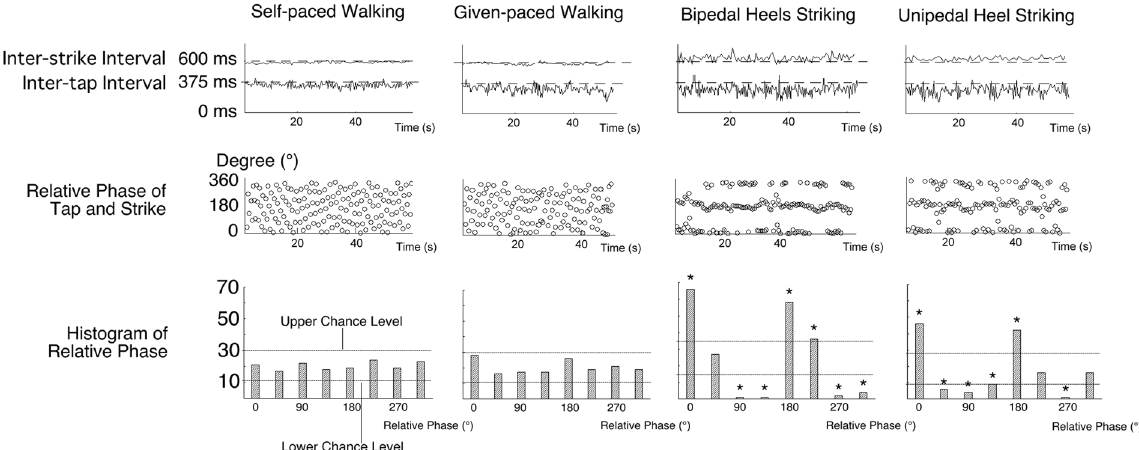
Figure 1. Representative examples of responses for four tasks (self-paced walking, given-paced walking, bipedal heels striking, and unipedal heel striking) in one subject. The top graphs: Temporal changes in inter- strike and inter-tap intervals. Dashed lines indicate the target time intervals, 375 ms for finger taps and 600 ms for heel strikes. The middle graphs: Instantaneous relative phases of finger tapping and heel strikes. The bottom histogram: Number of the relative phase that occurred in 45° bins centered from 0° to 315°. Two lines in each histogram indicate the upper and lower limits of the chance level. * Indicates a value outside the limits (P <